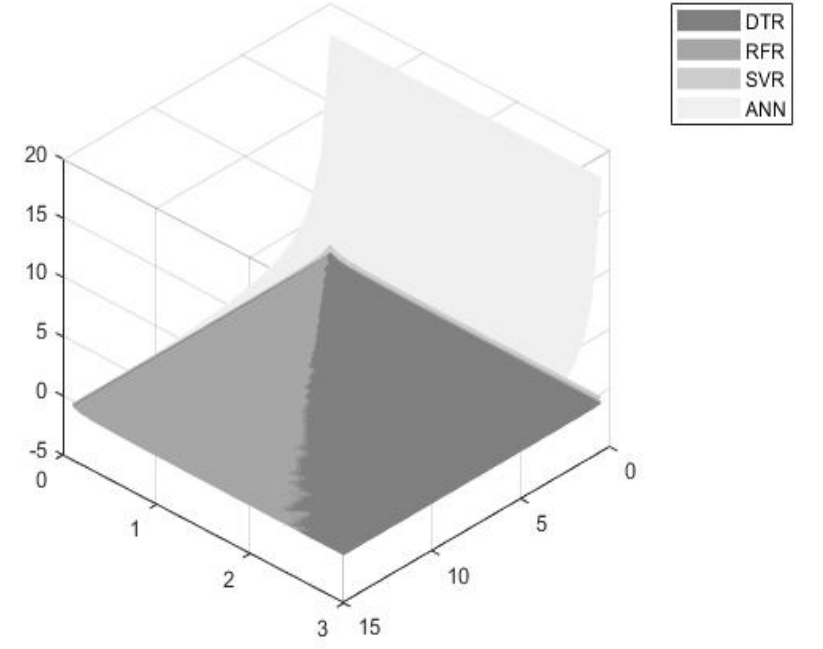
Figure 2. Sensitivity analysis of accuracy and time threshold values with w a = 10%, 1 − w a = 90%.